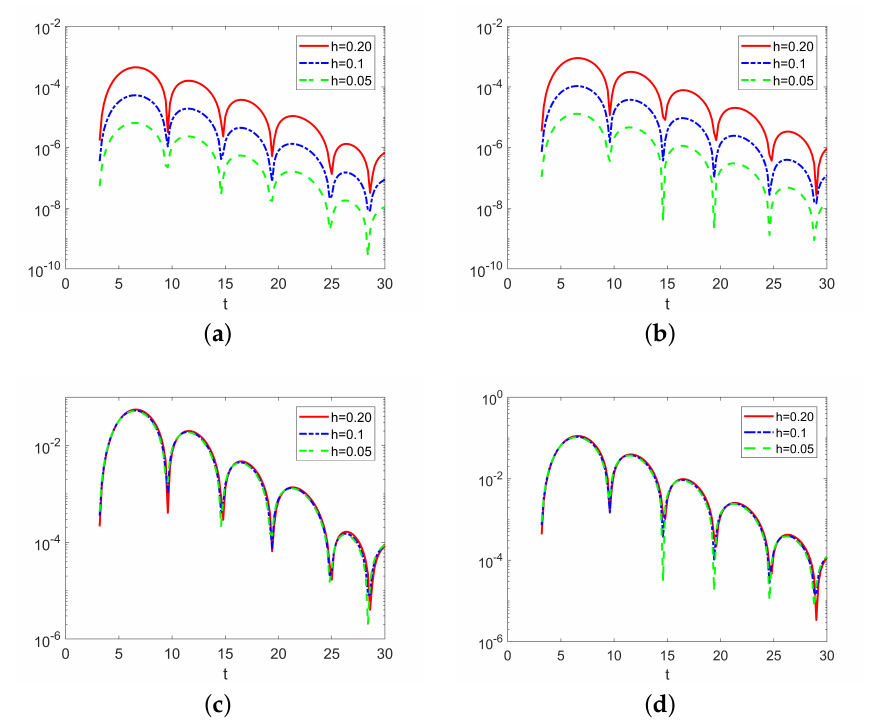
Figure 3. Errors (log-scale) of numerical solutions for Example 1, computed with the method T 3 using three different mesh sizes. ( a , b ) Absolute errors for the first and second component, respectively. ( c , d ) Errors divided by h 3